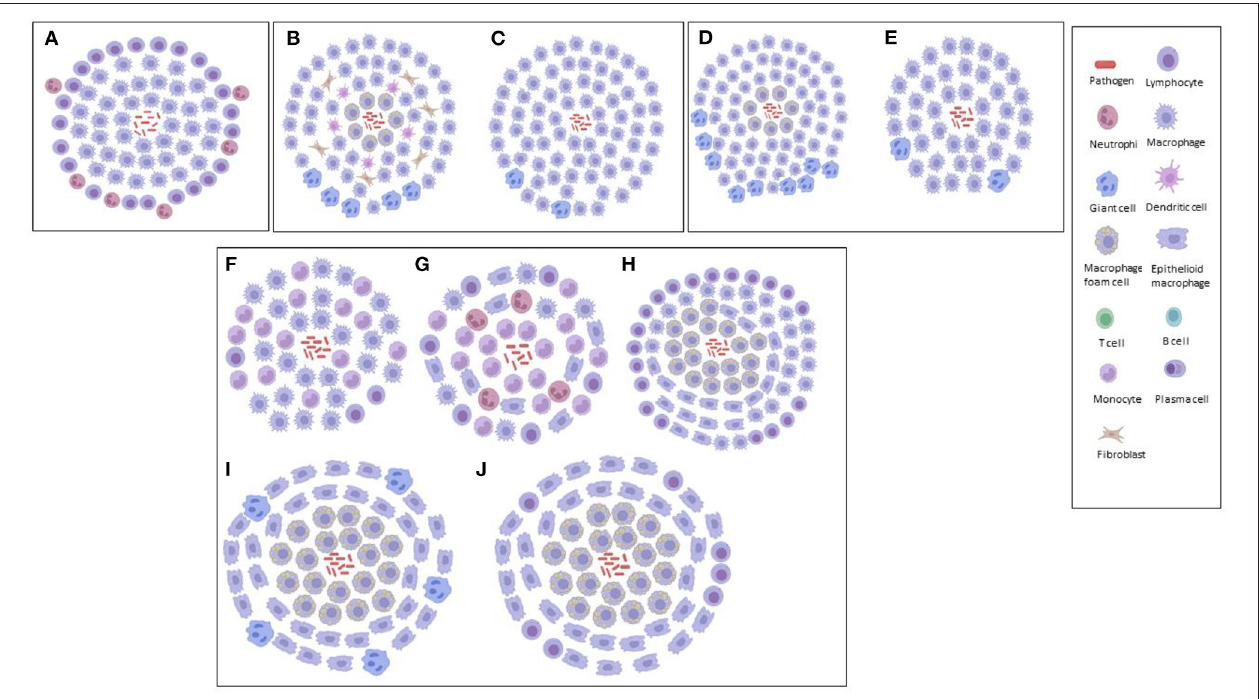
FIGURE 1 | Graphical illustrations of TB granulomas based upon key cellular elements in their categorizations, based upon literature. (A) Foreign body-type and hypersensitivity granuloma. (B) Caseous and cavitary granuloma. (C) Solid granuloma. (D) Caseous and fibrocaseous granuloma. (E) Nasent granuloma. (F) Category